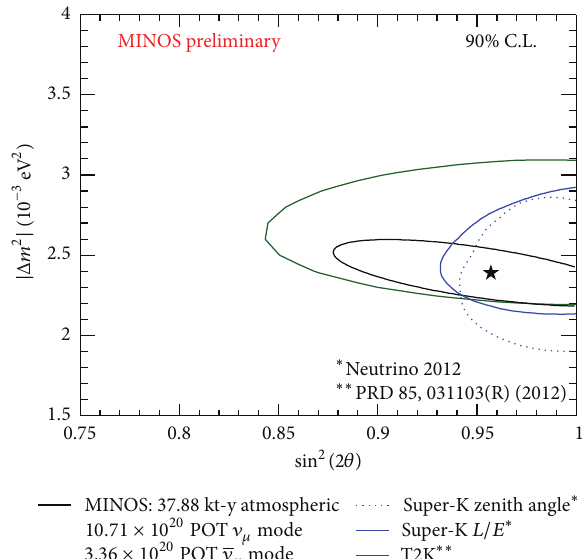
Figure 14: Preliminary 90% confidence regions for |Δ𝑚 2 | and sin 2 (2𝜃) (except for T2K, which is published). Results are shown for MINOS [45], T2K [48], and Super-Kamiokande [47]. The MINOS results shown here are a combination of NuMI beam data and atmospheric neutrino data.